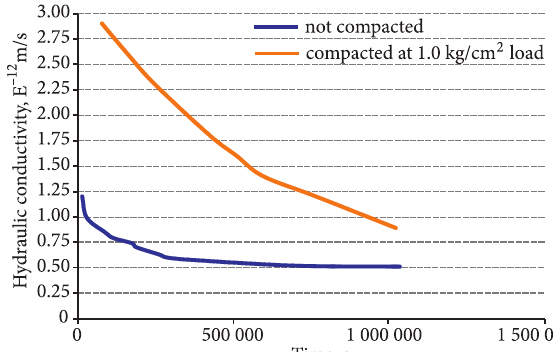
Fig. 6. Dependence on the hydraulic conductivity and the filtration time of clay paste